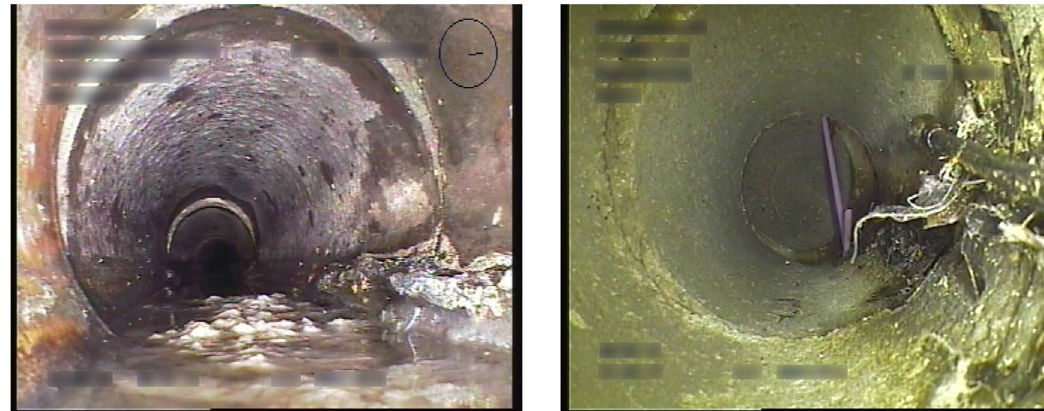
Fig. 18 Example of anormaly pipe images